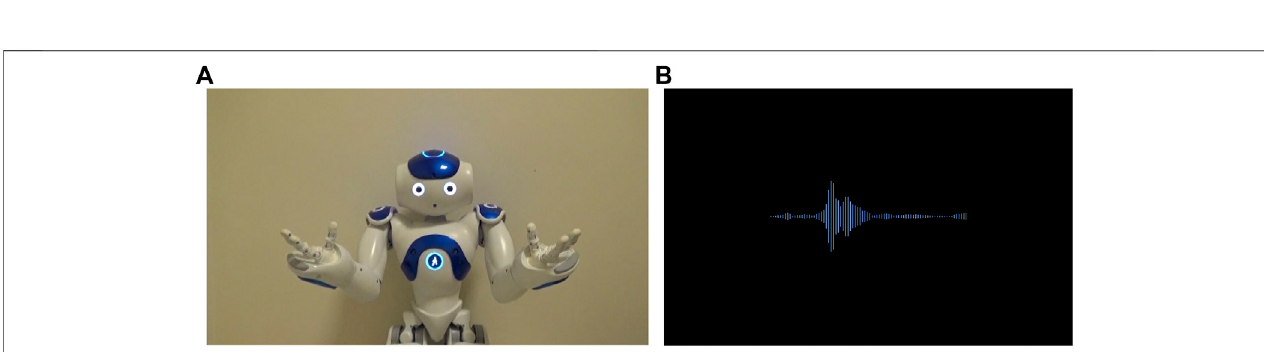
FIGURE 2 | The appearance of the robot tutor (A) and the voice tutor (B) . See Supplementary Material for the videos of the robot and voice tutors).